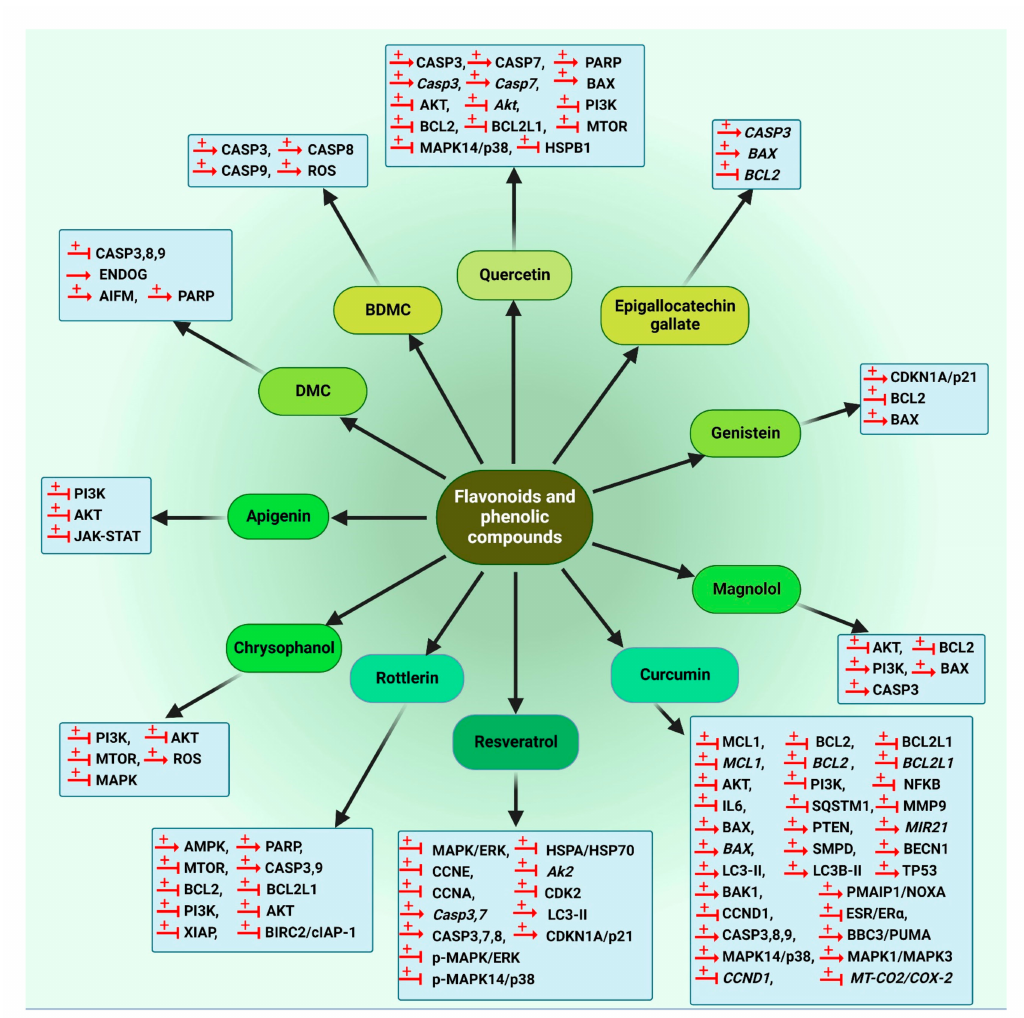
Figure 7. The schematic role of alkaloids on different proteins involved in the autophagy pathway. Figure 16. The schematic role of flavonoids and phenolic compounds on the proteins involved in Alkaloids regulate autophagy in different ways. Vincristine and carbazoles have been demonstrated the apoptosis pathway. PI3K inhibition, AKT dephosphorylation, activating caspases, dissociation to inhibit autophagy by suppression of CD24, suppression of the PTEN-AKT-MTOR pathway and of BAX from BCL2L1, increased PARP and generation of ROS are detectable changes in different enhancement of SSQTM1/p62. Other alkaloids induce autophagy via activation of AMPK, TSC2, MAPK/JNK-AP-1 and BECN1, and enhance MYC/c-Myc, LC3-II and ATG7 expression. Moreover, inhibiting the AKT-MTOR pathway has a key function in induced autophagy by alkaloids. Moreo- ver, another alkaloid named tetrandrine induces autophagy by suppressing the WNT- CTNNB1/β - catenin pathway and decreasing MTA1 expression. → : Indicates activation or an increase in the mentioned protein expression.